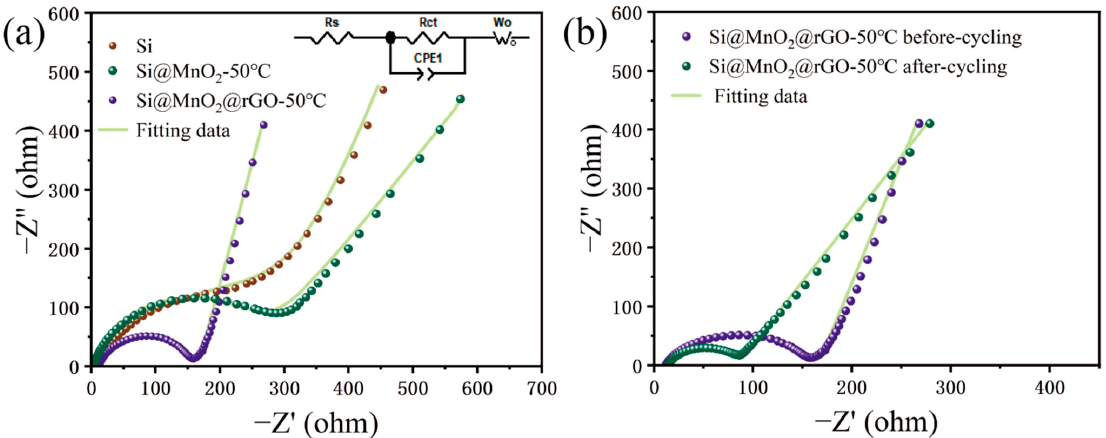
Figure 6. ( a ) The electrochemical impedance spectra of Si, Si@MnO 2 -50°C, and Si@MnO 2 @rGO-50°C. The inset shows the equivalent circuit model. ( b ) The electrochemical impedance spectra of the